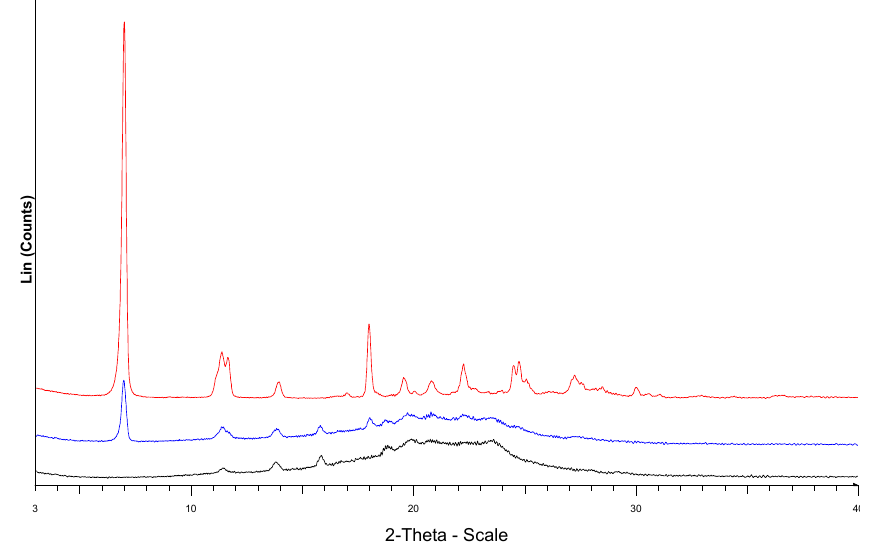
Figure 7. PXRD of ABZ (red), empty PU structures (black) and ABZ-PU (blue) particles.